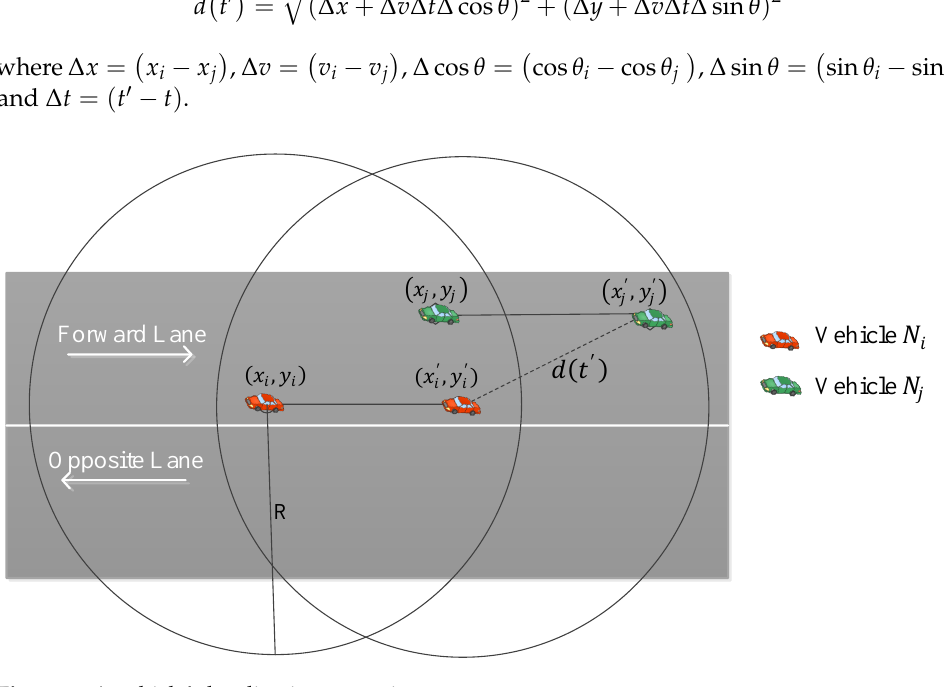
Figure 2. A v ehicle’s localization scenario. Figure 2. A vehicle’s localization